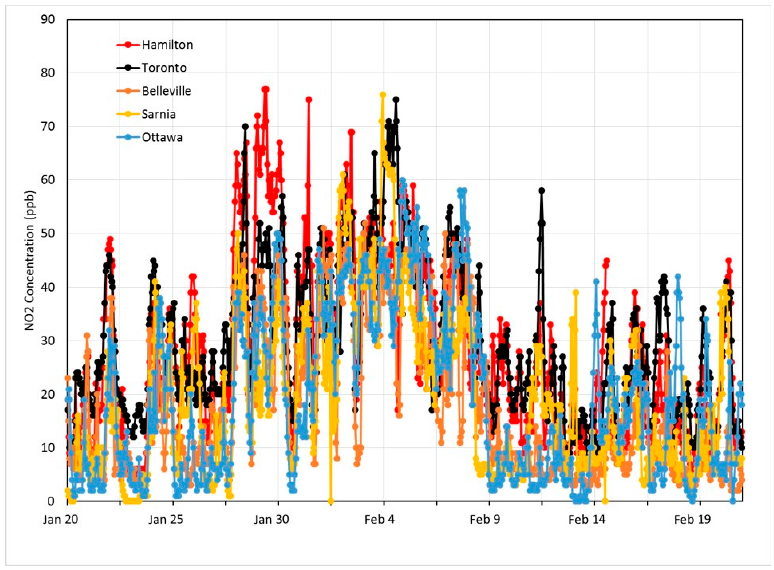
Figure 9. Daily maximum 1-h NO 2 concentrations, 20 January–20 February 2005.